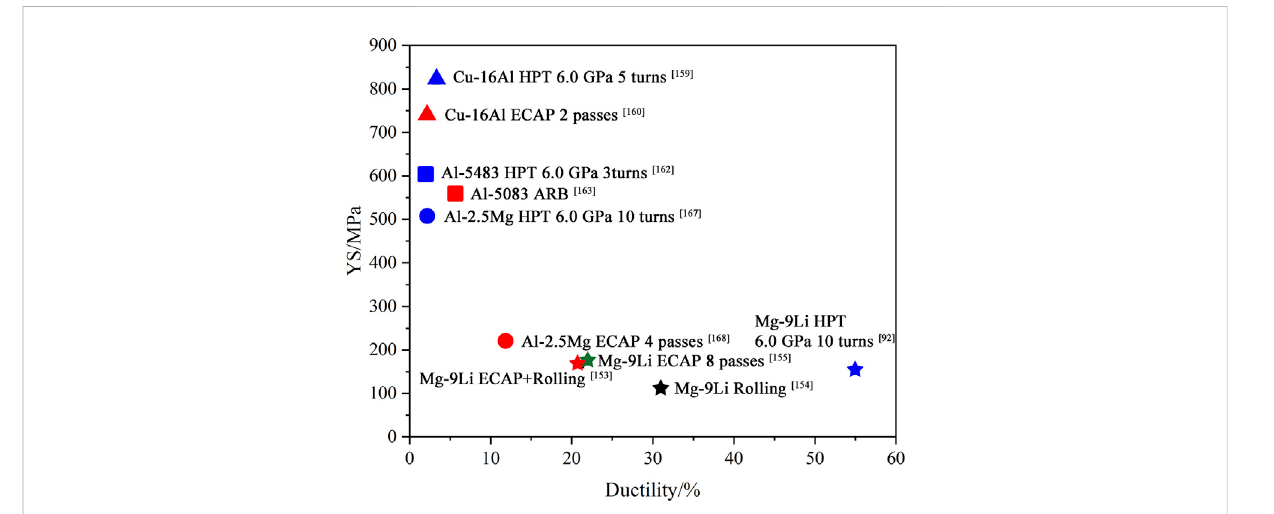
FIGURE 8 The comparison of metal processed by various SPD techniques in YS and ductility (Qu et al., 2009; Kapoor et al., 2010; An et al., 2011; Liu et al., 2013; Toroghinejad et al., 2013; Bazarnik et al., 2016; Zou et al., 2016; Su et al., 2018; Klu et al., 2019; Klu et al.,